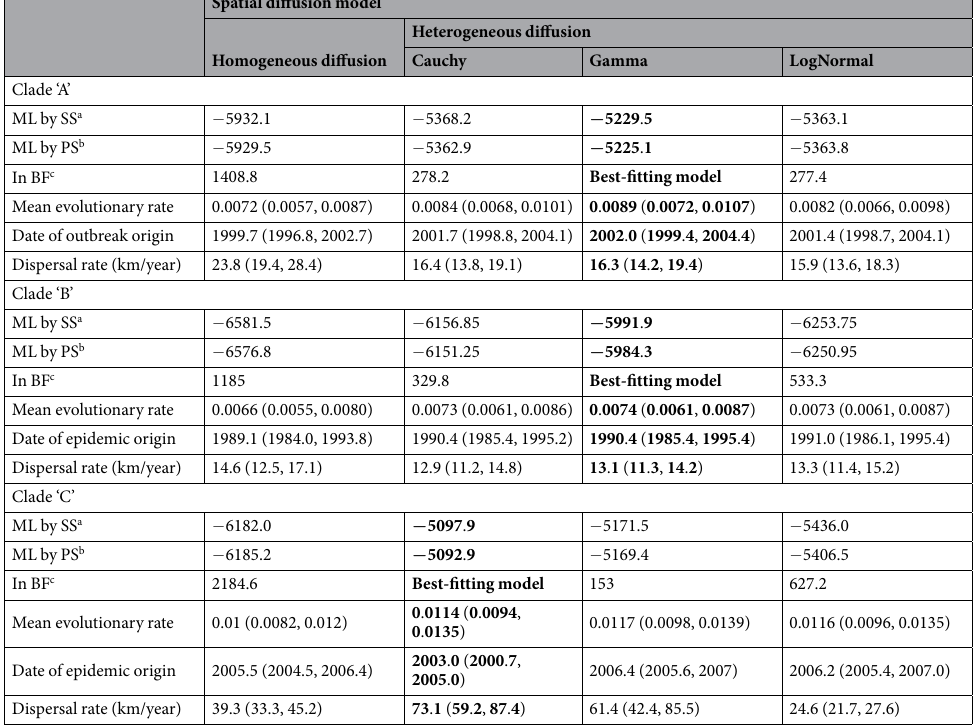
Table 2. Posterior estimates of spatio-temporal evolutionary parameters and comparisons under different spatial diffusion models. a Marginal likelihood estimated by stepping-stone. b Marginal likelihood estimated by path-sampling. c Bayes